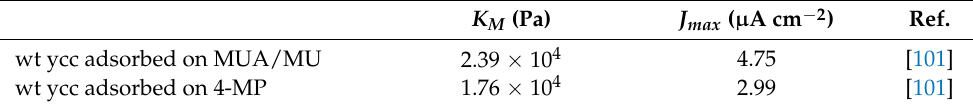
Table 3. Kinetic parameters for the electrocatalytic reduction of O 2 carried out by urea-unfolded bis-His form of yeast iso-1 cytochrome c (ycc) adsorbed on a polycrystalline gold electrode coated with a SAM of MUA/MU or 4-MP. For the solution composition, experimental conditions, and uncertainties associated with the reported values, the reader is referred to the original literature. K M (Pa) J max ( µ A cm − 2 )